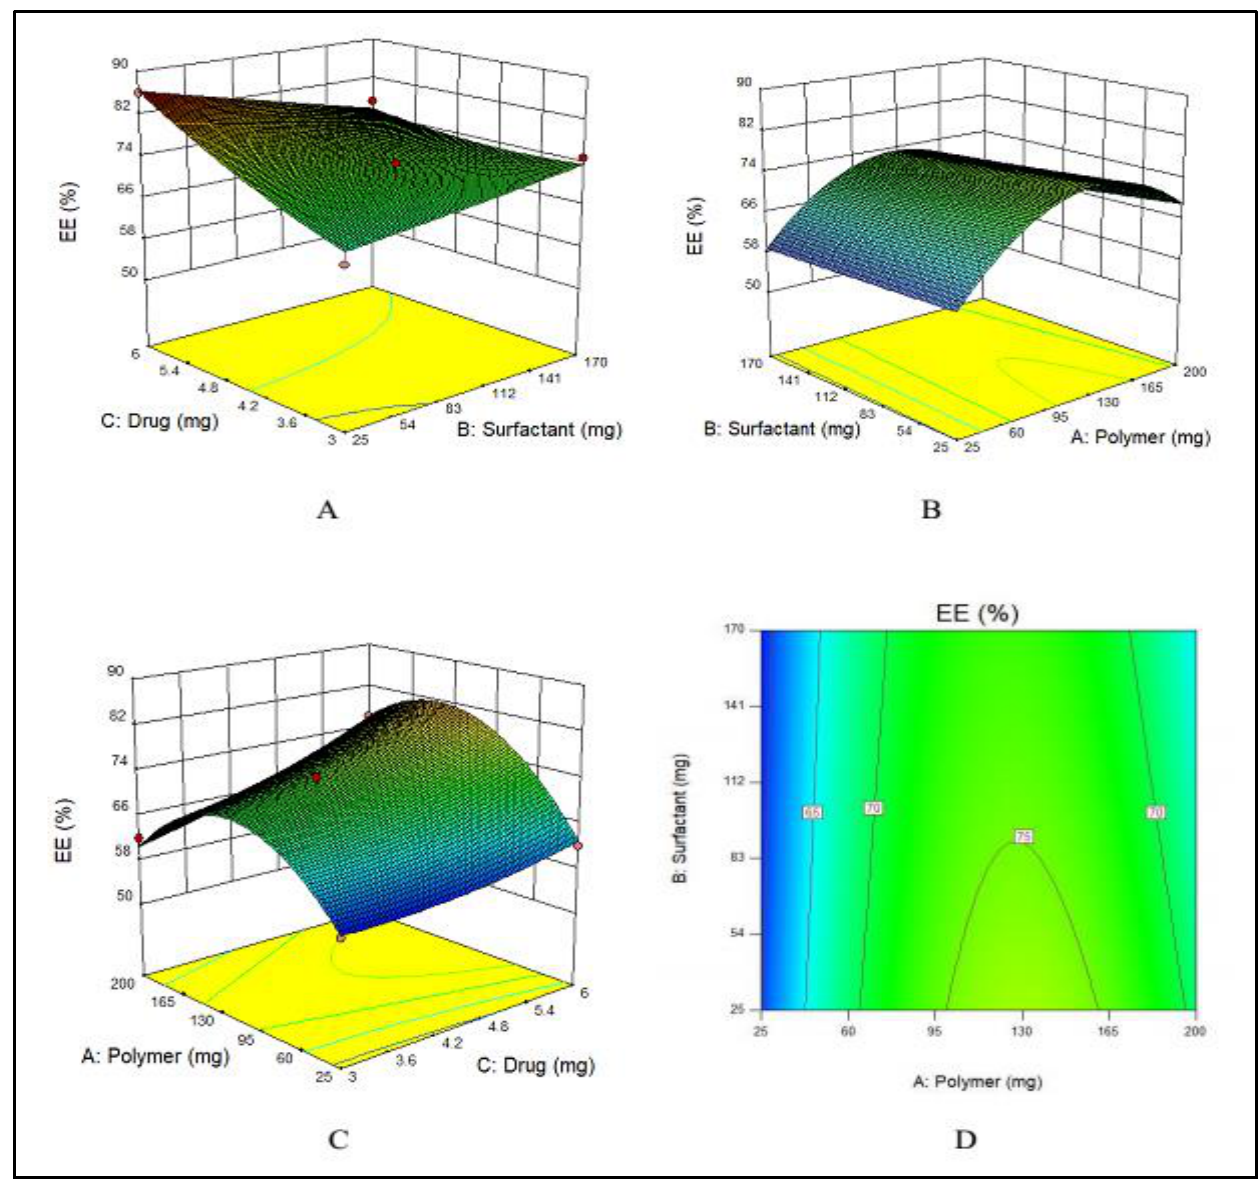
Figure 1. ( A ), ( B ) and ( C ) showing the 3D surface plot for impact of PVA (surfactant), E100 (polymer) and MTX (drug) on EE, respectively while ( D ) showing the combined effect of PVA, E100 and MTX on EE.